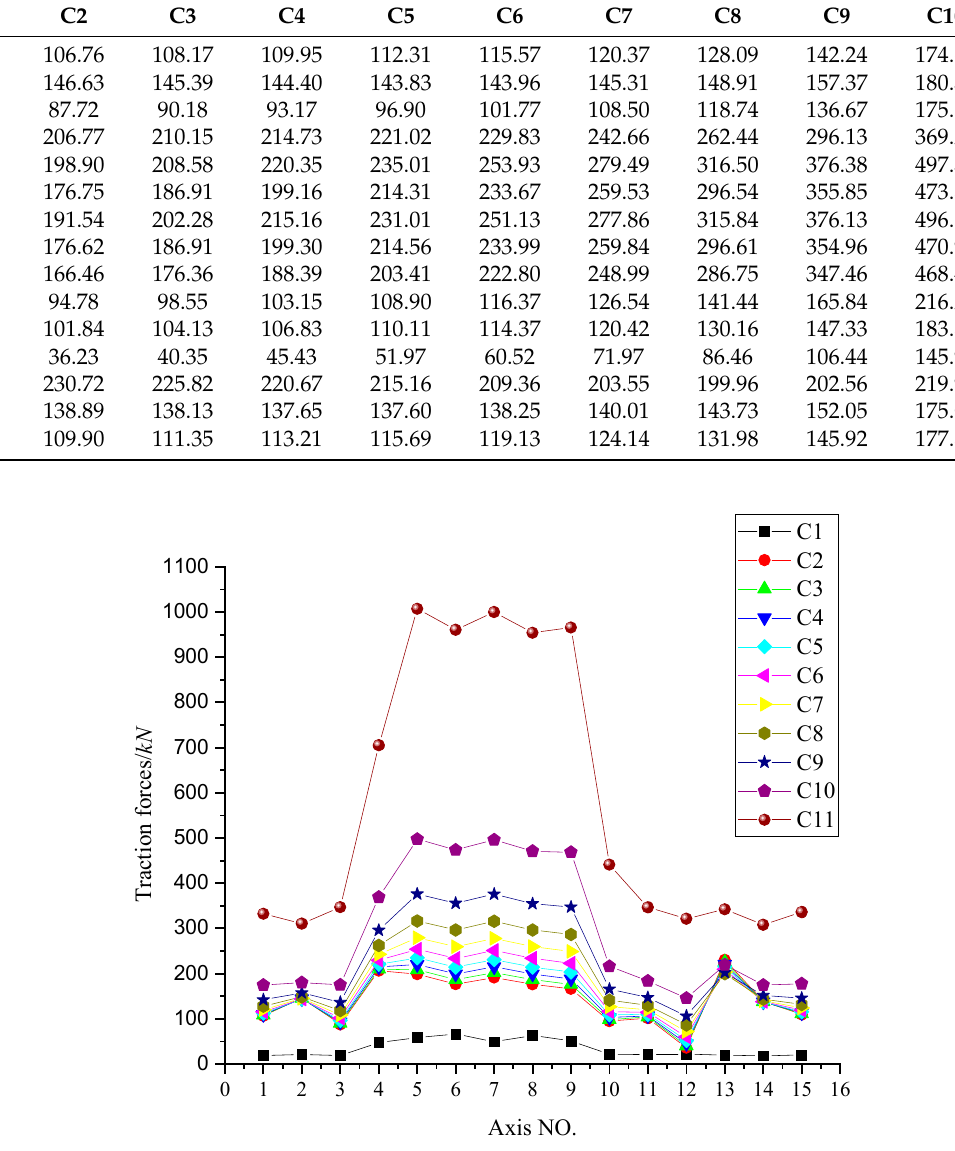
Figure 19. Variation curve of traction force.